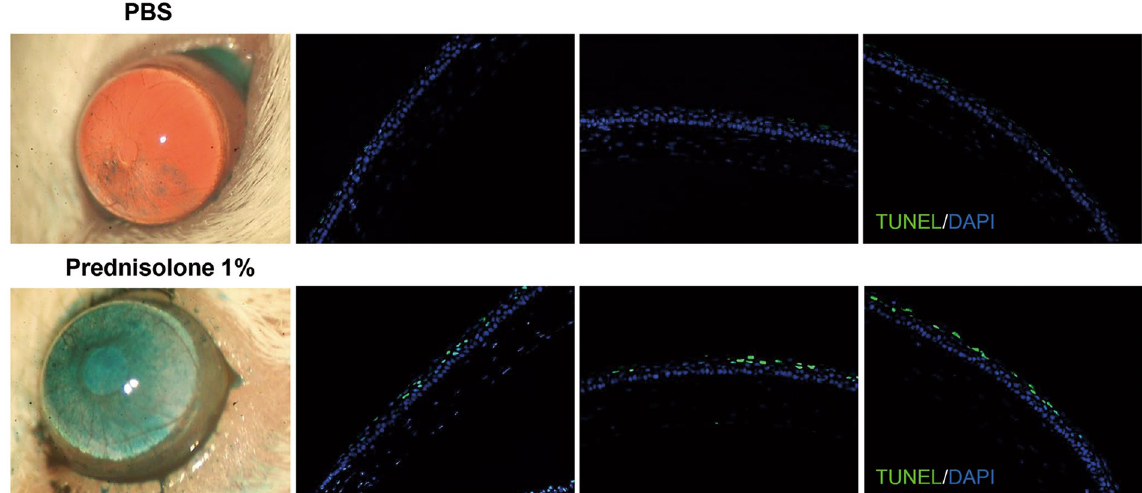
Figure 7. Effect of 1% prednisolone eye drops on the corneal epithelium in dry eye mice. Either 1% prednisolone acetate (Pred forte ® , Allergan, Irvine, TX) or the same volume of phosphate buffered solution (PBS) was topically applied QID for 7 days to eyes of 12-week-old female NOD.B10.H2 b mice (six animals in each group). Representative corneal photographs after lissamine green staining and TUNEL staining of the corneal epithelium are shown. Original magnification